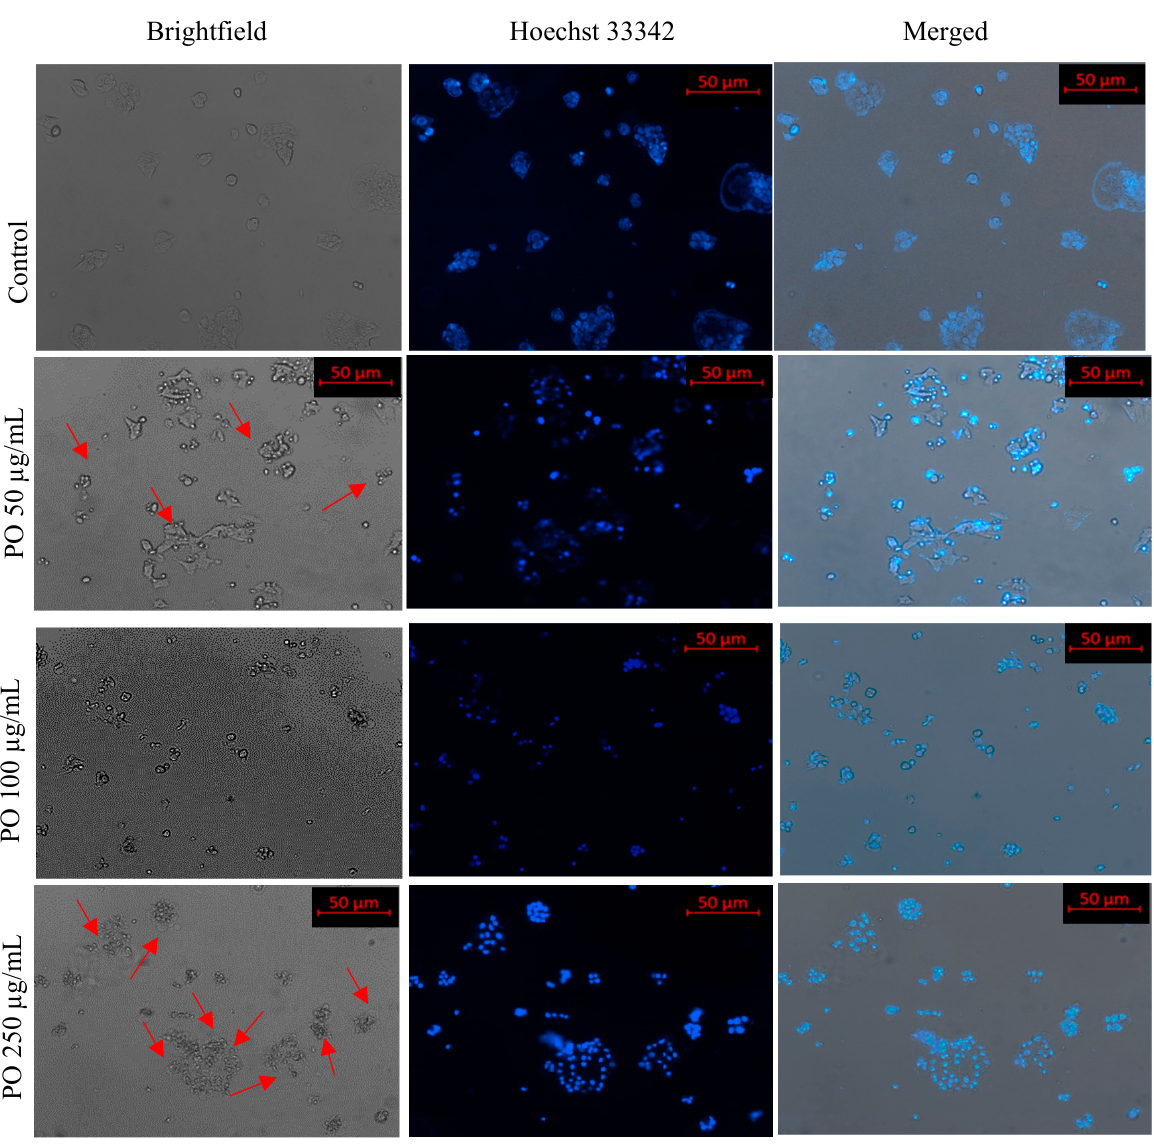
Figure 7. Nuclear morphology of MCF-7 cells after DAPI staining. The fluorescence microscopy images (at 10×) of cells treated with different concentrations of EEPOs show condensed nuclei, high fluorescence and cell shrinkage as compared to the negative control, which does not exhibit such nuclear changes. Red arrowhead: Cell apoptosis in treatment group.